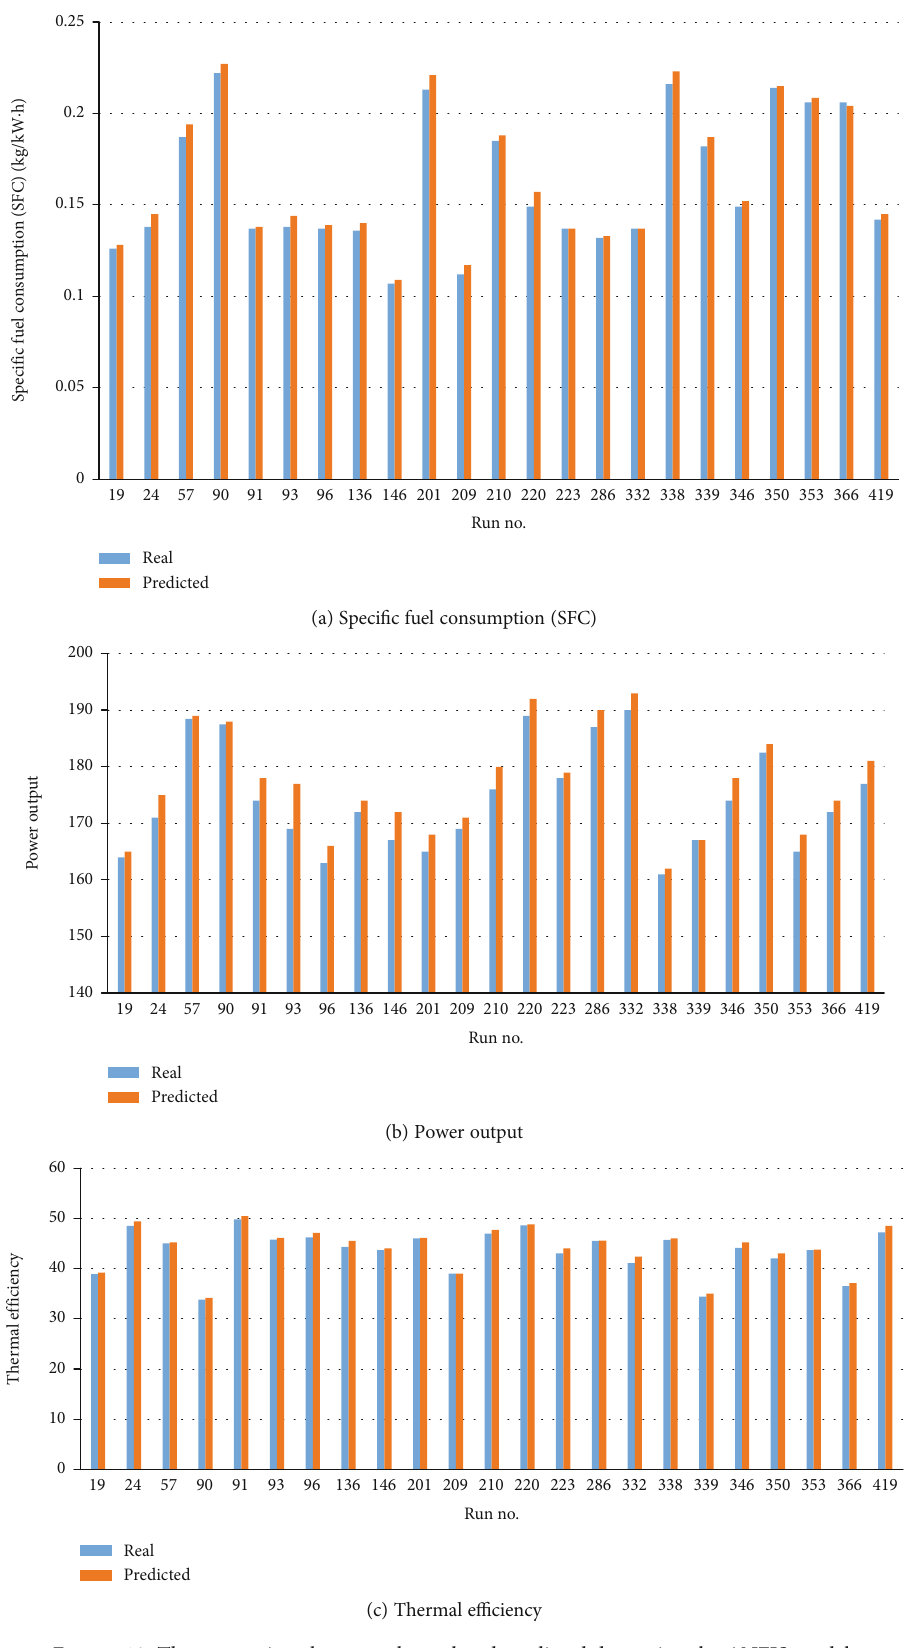
Figure 12: The comparison between the real and predicted data using the ANFIS